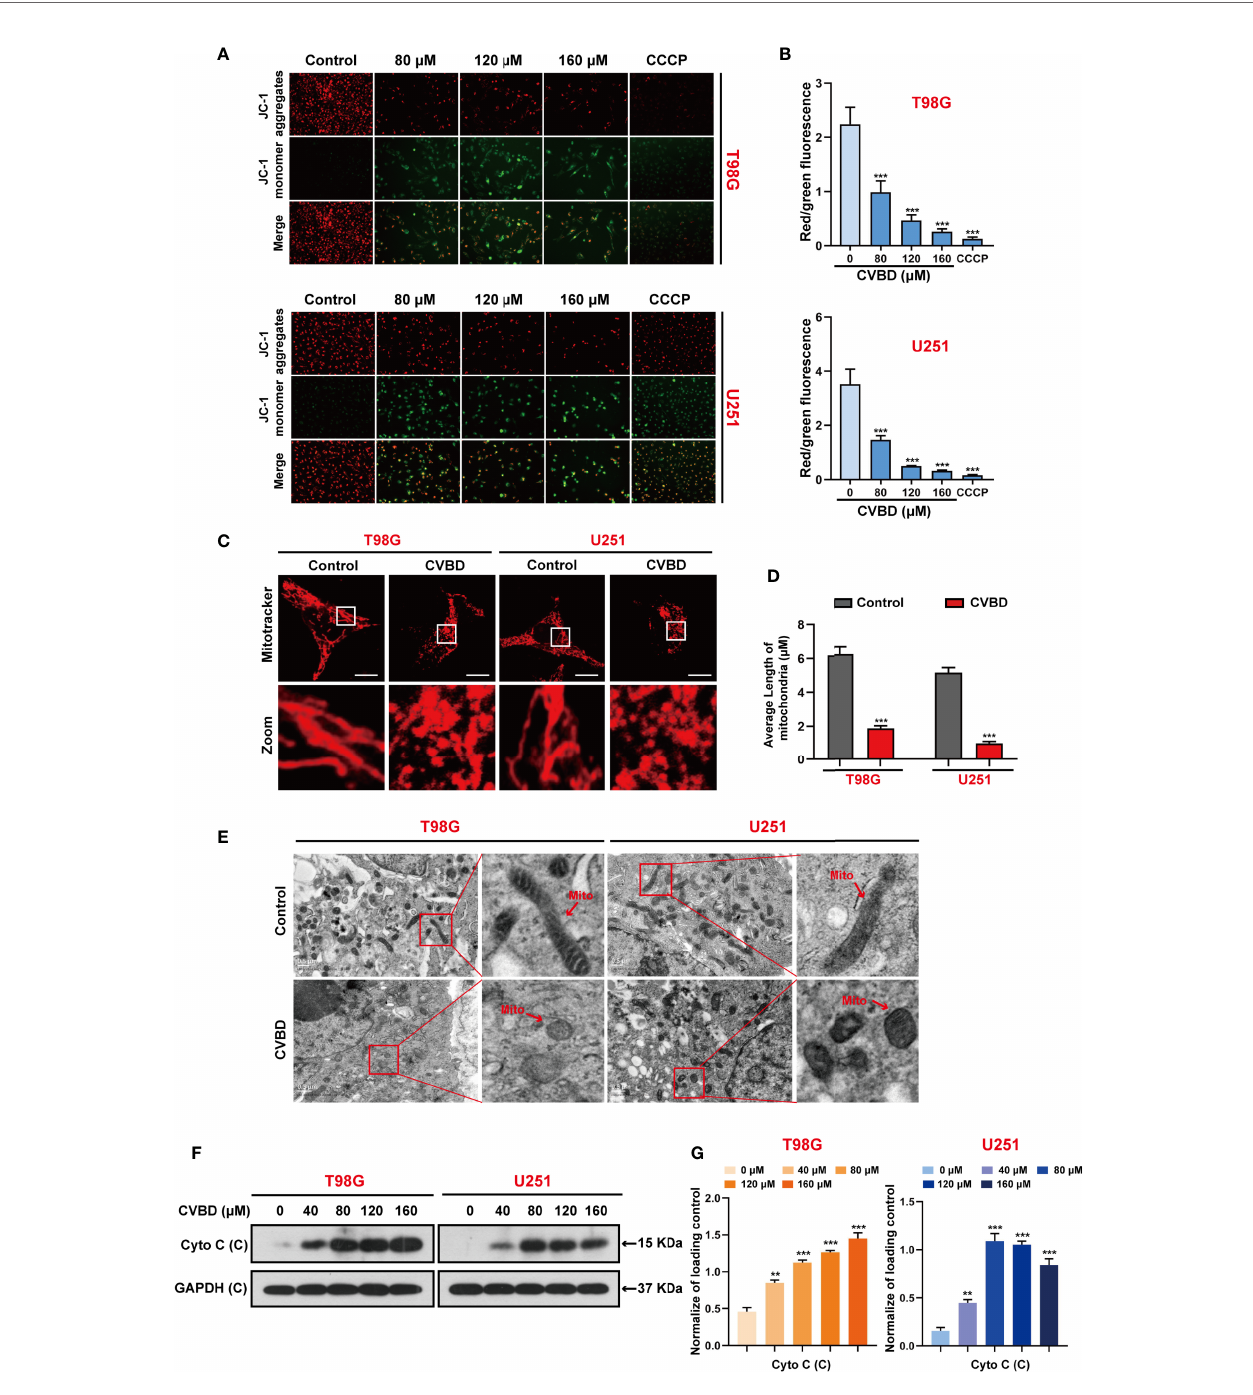
FIGURE 3 | CVBD induces mitochondrial damage in GBM cells. (A, B) T98G and U251 cells were exposed to various concentrations of CVBD (80, 120, 160 m M) for 24 h, and 0 m M CVBD was used as the control group. CCCP was used as the positive control (50 m M, 30 min). The mitochondrial membrane potential (MMP) was detected by a fl uorescence microscope using JC-1 probe staining (mean ± SD of three independent experiments ***P < 0.001 compared with the control group). (C, D) T98G and U251 cells were treated with CVBD (120 m M) for 24 h. Mitochondrial morphology was observed using MitoTracker (Deep Red FM) staining followed by confocal microscopy. Scale bars: 10 m M. The average length of the mitochondria was measured by Image J software (mean ± SD of three independent experiments, ***P < 0.001 compared with the control group). (E) Representative TEM images of T98G and U251 cells, treated as indicated in (C) . Red arrows indicate mitochondria. Scale bars: 0.5 m M. (F, G) T98G and U251 cells were treated with various concentrations of CVBD for 24 h. The expression level of Cyto C in the cytoplasm was detected by Western blotting analysis. GAPDH was used as a loading control (mean ± SD of three independent experiments, **P < 0.01, ***P < 0.001 compared with the control